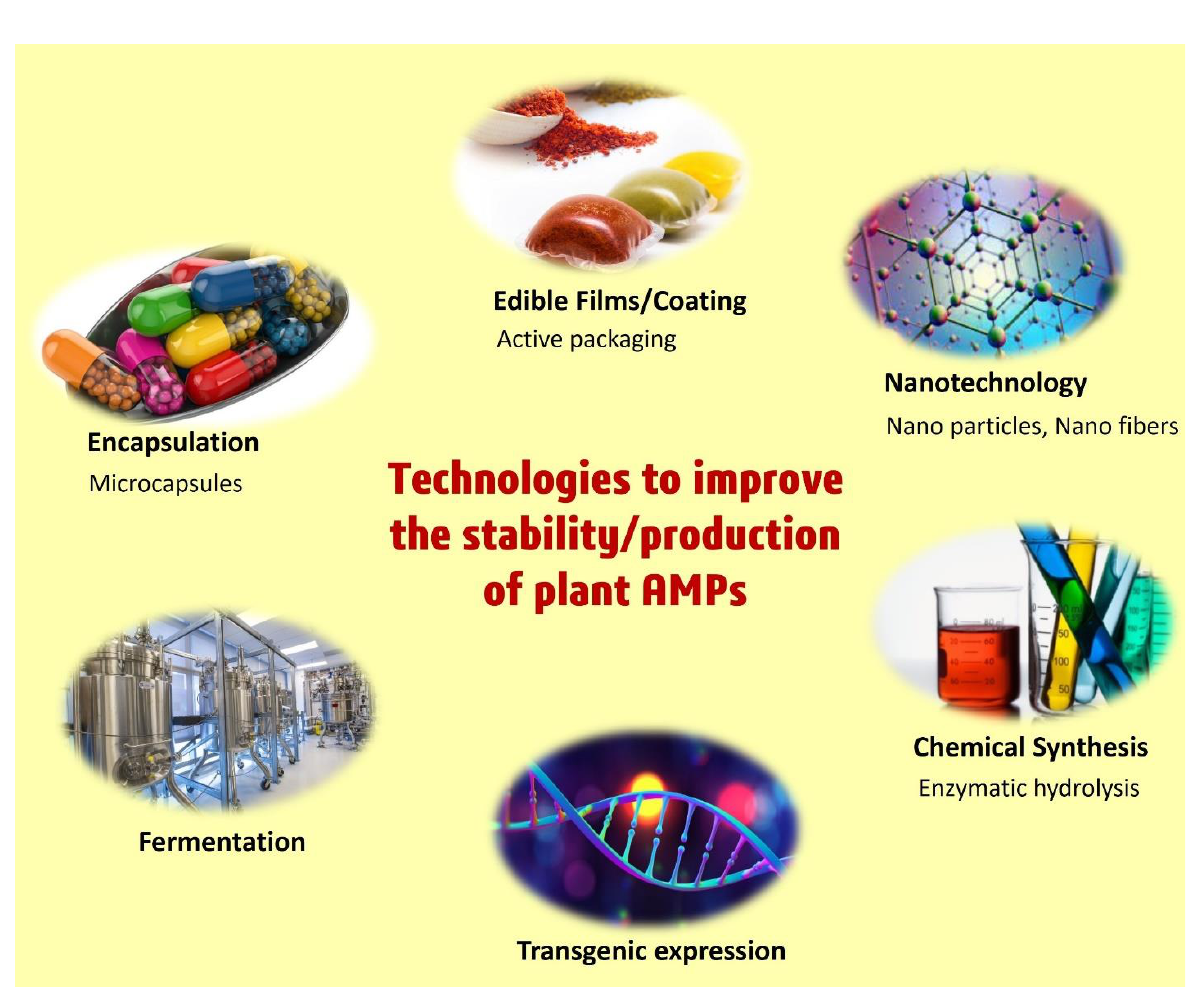
Figure 6. Different scientific technologies for the stability and production improvement of raw, processed, and liquid food, using plant AMPs.